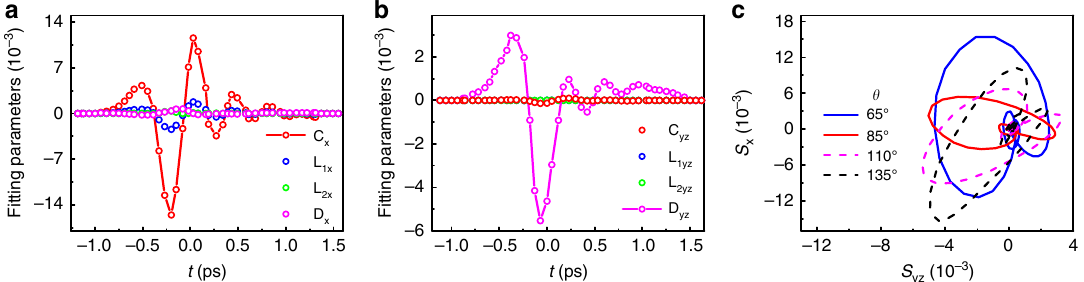
Fig. 4 The obtained THz EO signals by rotating the quarter-wave plate. a – b Time-dependent fi tting parameters C λ , L 1 λ , L 2 λ , and D λ ( λ = x , yz ) in Eq. (1). c shows the polarization trajectory ( S yz ( t ), S x ( t )) under elliptically polarized pump light with different θ . The solid and dashed curves represent opposite